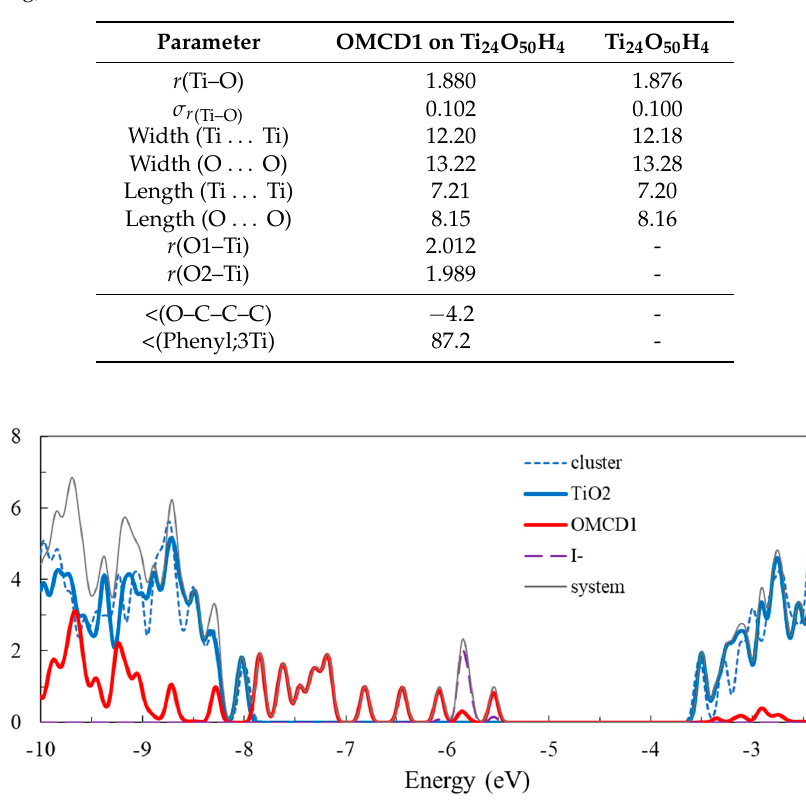
Figure 13. Density of states of the OMCD1–Ti 24 O 50 H 4 system, compared to the bare Ti 24 O 50 H 4 cluster, calculated by DFT at the B3LYP/LANL2DZ level in water solvent. The contributions of the various atoms are: Ti, blue; O, red; –OH groups, grey; dye molecules, black; iodine anion, green. Energy levels were convoluted with Gaussian distributions with a full width at half maximum of 0.1 eV